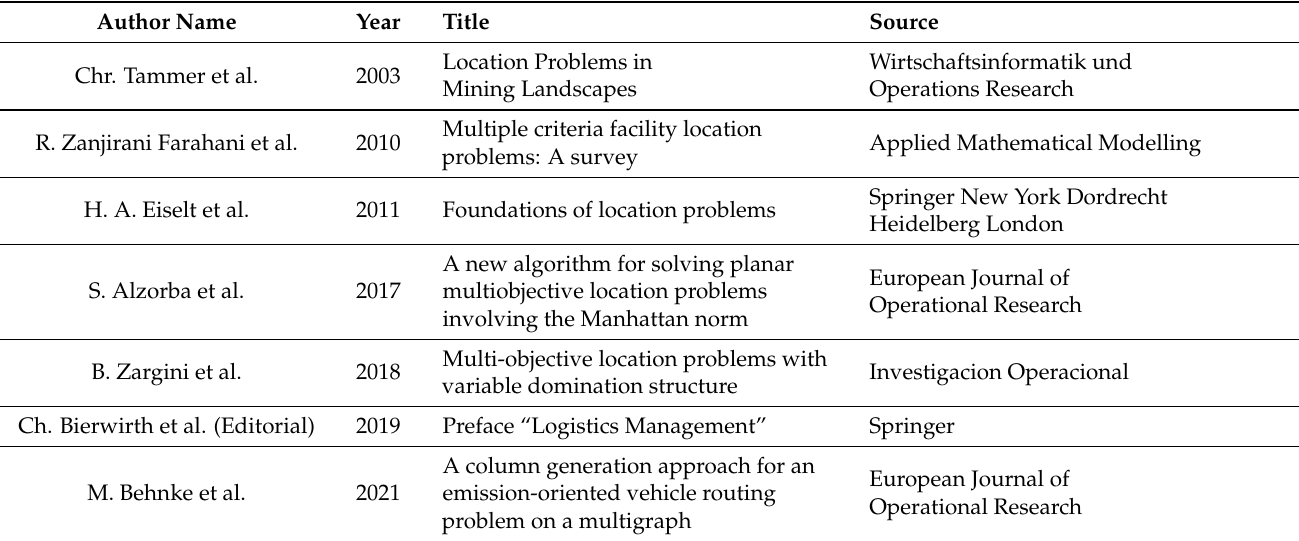
Table 1. Literature review